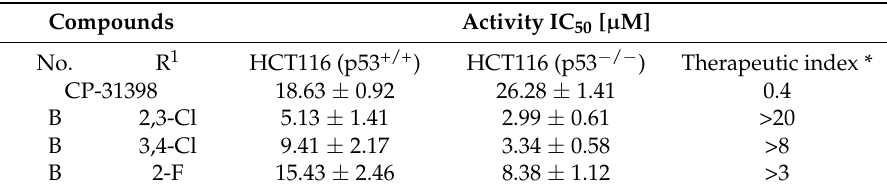
Table 1. Selected activities of styrylquinolines B (R=H, see Scheme 4) against wild type and p53 null colorectal cancer cells